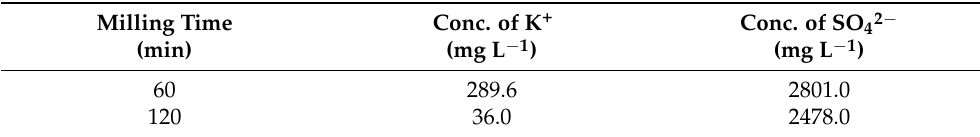
Figure 3. TGA patterns of kaolinite-K 2 SO 4 (3:1 mass ratio), various milling times, 700 rpm. Significant and clear effects are obtained for time milling for release of K + and SO 4 2 − nutrients from kaolinite- K 2 SO 4 mixtures milled at 700 rpm, as shown in Table 2. The release rate of the nutrients decreases as the kaolinite content increases. The milling rotational speed was kept constant at 700 rpm for varied milling times during sample preparation. Table 2. The concentration of K + and SO 42 − nutrients released from kaolinite-K 2 SO 4 sample mixture after milling at 700 rpm for different milling